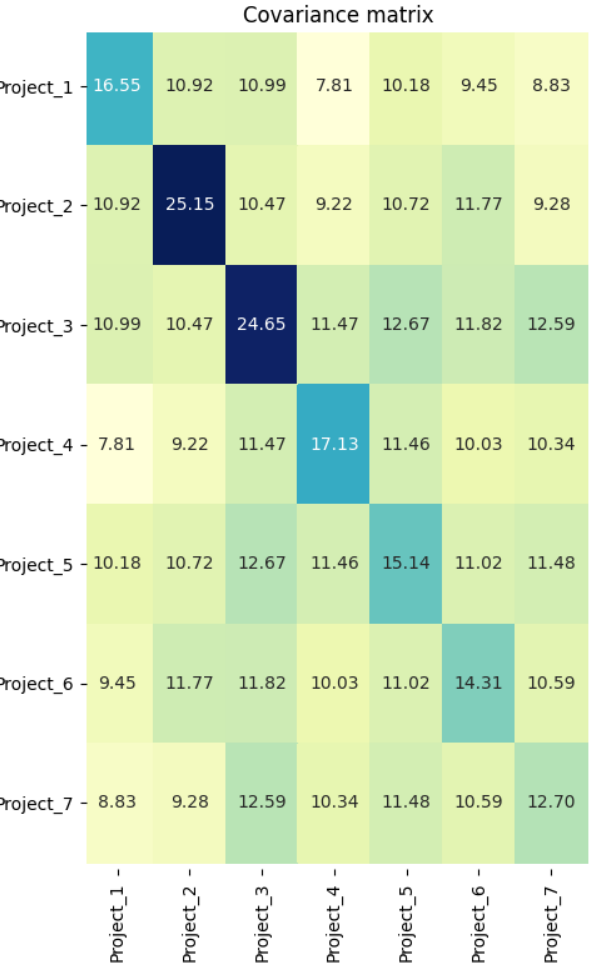
Figure 4. Histogram and theoretical curve of distribution of projected specific value ( V R m т ject No. 1 for the procurement of raw materials from corn waste, EUR/ton.